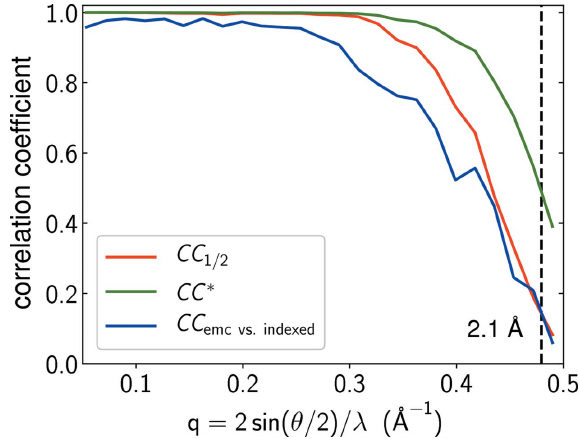
Figure 6 The correlation coefficients that validate the quality of our reconstruc- tion. The values of CC 1/2 show the correlation between Bragg intensities reconstructed independently from two halves of the data frames. Using equation (10), the values of CC*, the correlation coefficient between reconstructed intensities and the underlying true signals, are estimated from the values of CC 1/2 . The other correlation coefficient, CC emc vs. indexed , measures the consistency between our reconstructed intensities and those obtained by Martin-Garcia et al. (2017) from the indexed